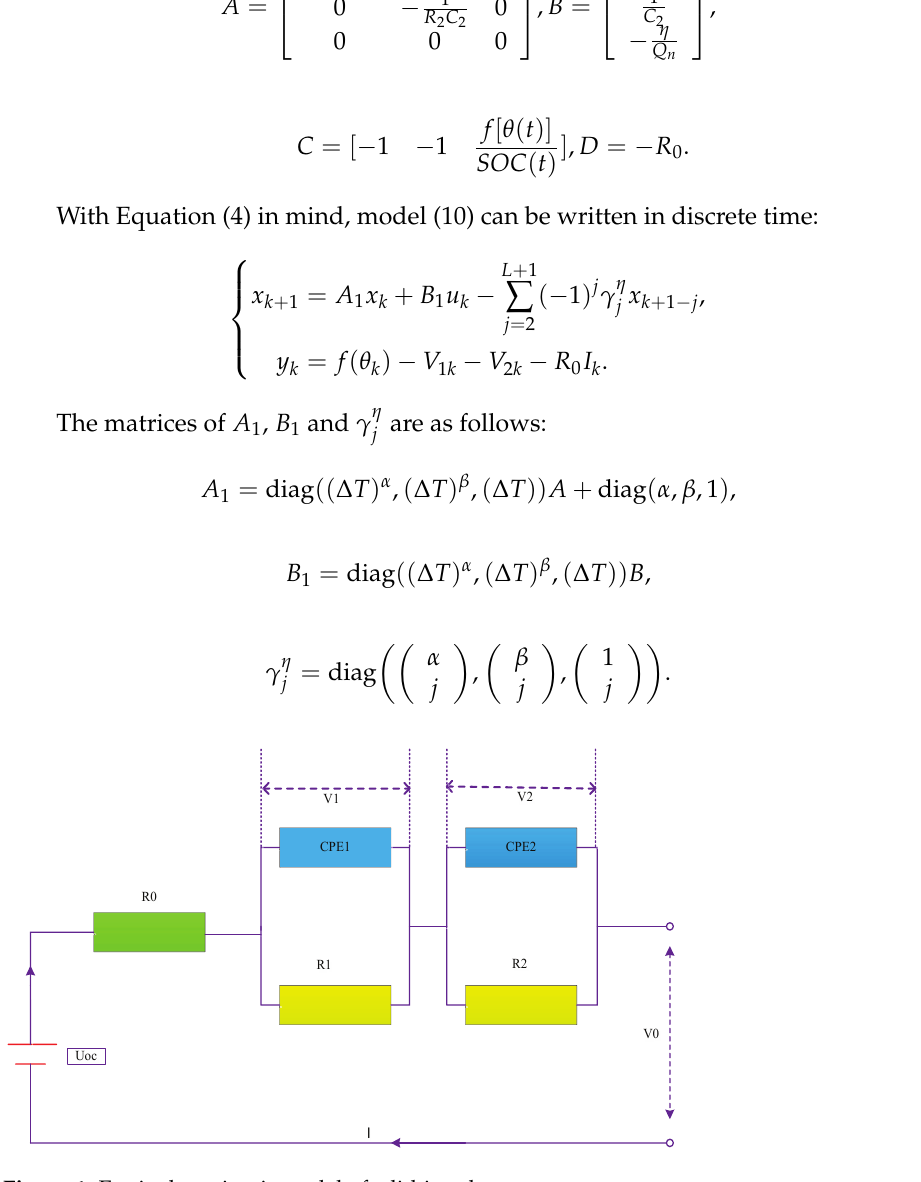
Figure 1. Equivalent circuit model of a lithium